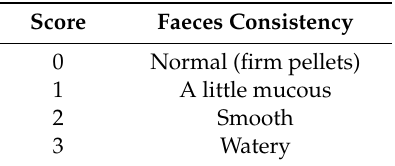
Table 1. Classification of diarrhoea